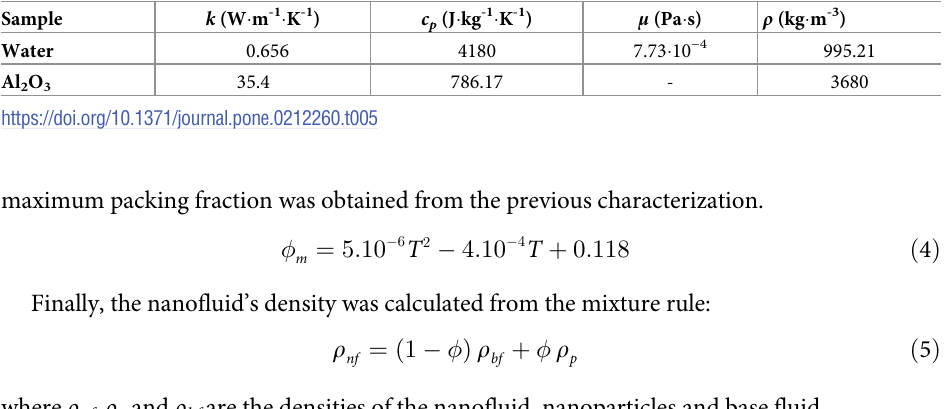
Table 3. Thermo-physical properties of water and alumina at T = 31.5˚C.